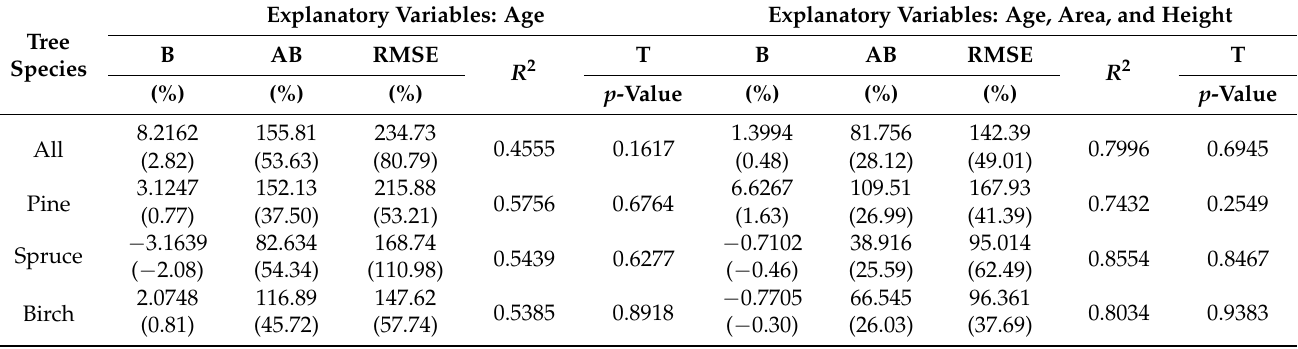
Table 7. Statistical measures and p -values of the Student’s t -test for the predictions of the tree basal area (individual-tree